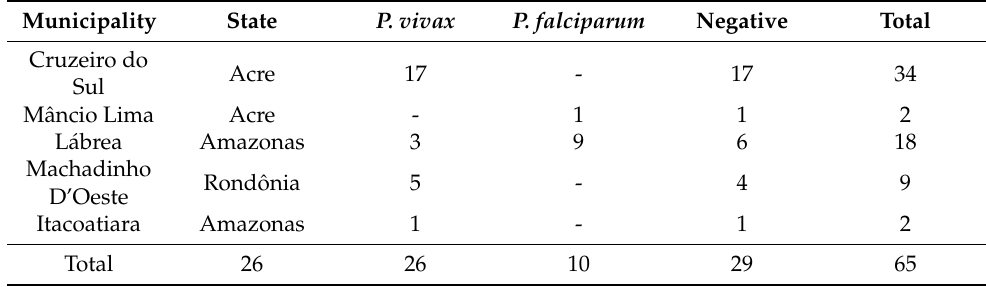
Table 1. List of adult Ny. darlingi females used in the study by locality and infection